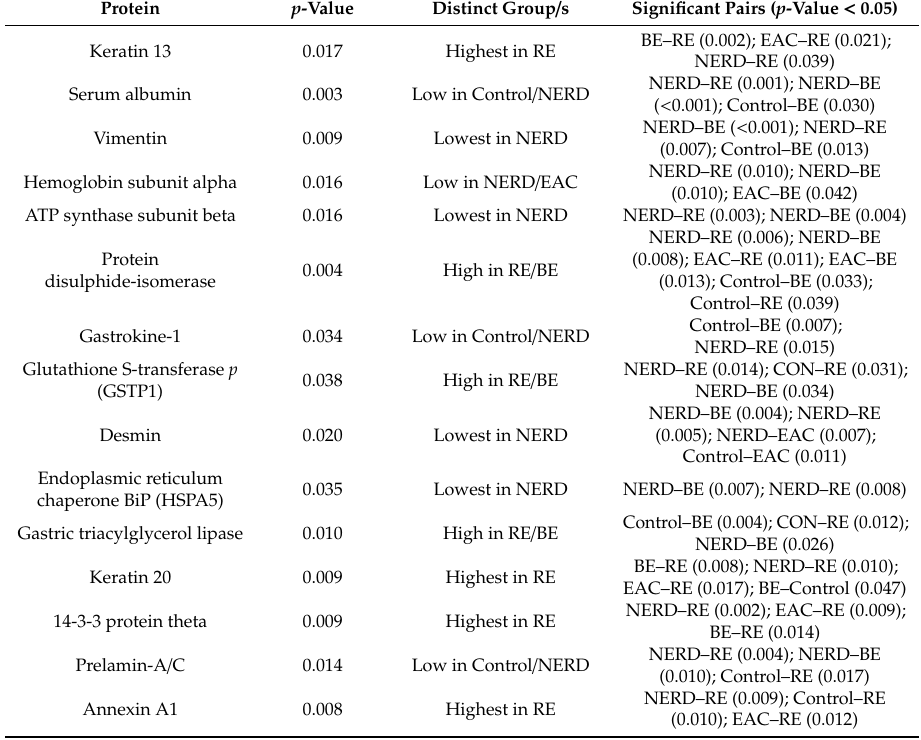
Table 3. Significant pairs within the 15 di ff erential proteins between non-erosive reflux (NERD), reflux esophagitis (RE), Barrett’s esophagus (BE), esophageal adenocarcinoma (EAC), and